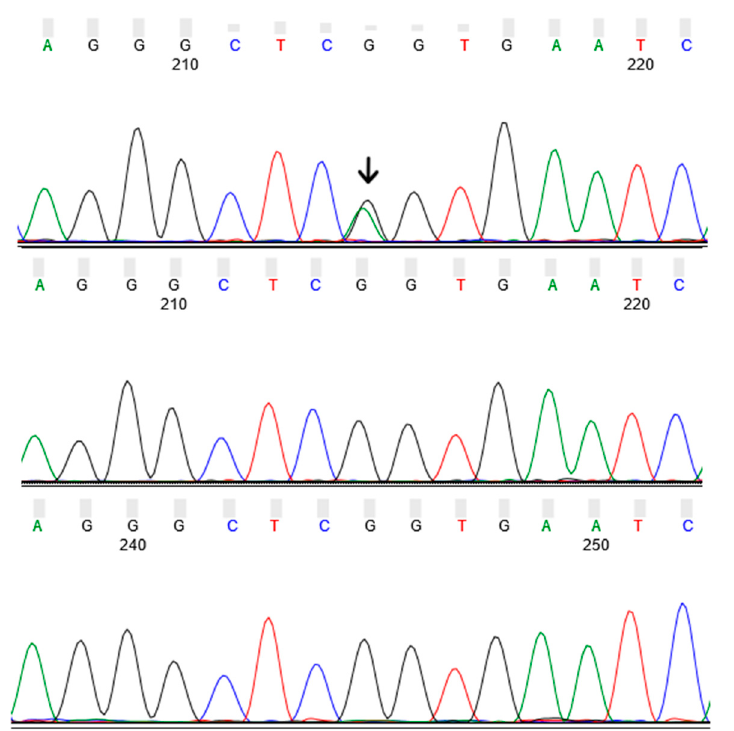
Figure 4. Sanger sequencing results of GBA p.R202X in Family 1. The top panel shows the presence of the G/A (heterozygote) genotype in the affected son of the index case and its absence from the two unaffected sisters. No DNA was available for GBA p.R202X Sanger sequencing of the index case. Targeted sequencing of PD genes revealed the presence of GBA p.R202X in both Family 2